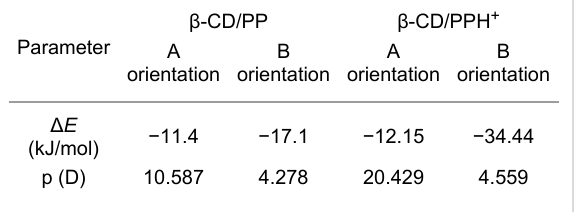
Table 5: Molecular parameters of the most stable β -CD/PP and β -CD/ PPH + inclusion complexes in A and B configurations, as given by the in aqua PM3 calculations.